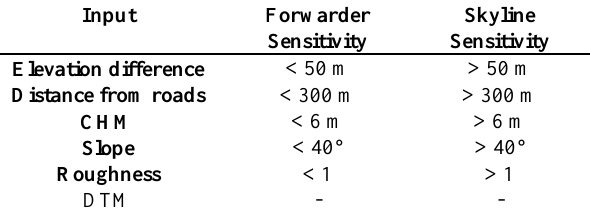
Figure 6. Sensitivity for the two classes of the RF classification.